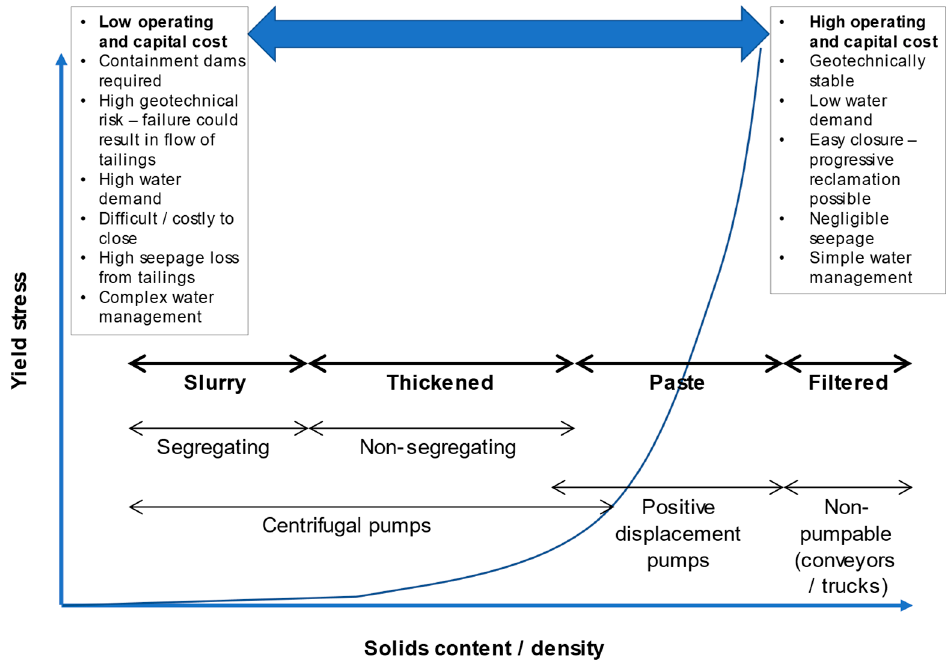
Figure 1. The tailings continuum, after Davies and Rice (2001) [15] and Jewell and Fourie (2006) [16]. Thickened and paste tailings technologies have many potential benefits, namely re- duced water consumption, reduced waste volumes and improved geotechnical stability, whilst maintaining relatively low operating